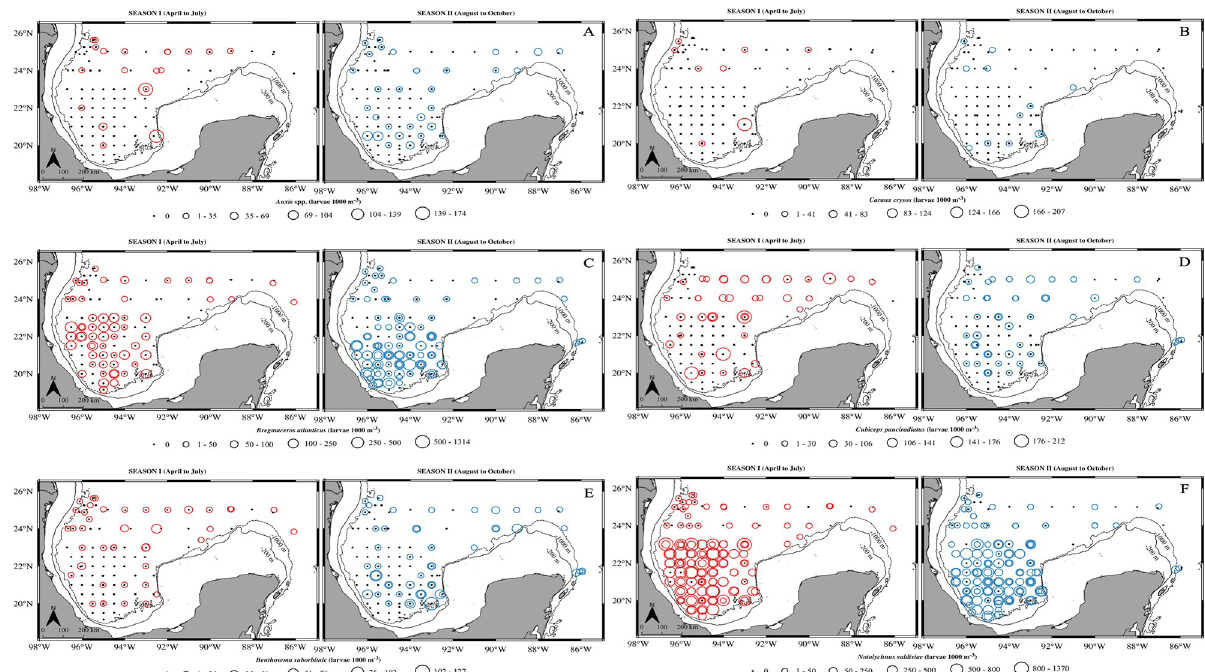
Fig 2. Season-specific spatial distribution of density of larval fish taxa. A: Auxis spp., b: Caranx crysos , c: Bregmacero s atlanticus , d: Cubiceps pauciradiatus , e: Benthosema suborbitale , f: Notolychnus valdiviae . First (second) column with red (blue) dots represents season I: April-July (season II: August-October). Circle size represents the density (larvae 1000 m -3 ) for a given location, with the scale adjusted for each species. Overlapping circles indicate samples from different cruises. Black dots indicate the absence of larvae. Continuous and dashed lines represent the 200 m and the 1000 m isobaths, respectively. https://doi.org/10.1371/journal.pone.0280422.g002 (Table 5). The models for the neritic C . crysos had a very low explained deviance ( < 0.1) in both seasons and were discarded. For Auxis spp., season I was the model with the highest explained deviance, and all models in season I presented a higher deviance explained than in season II (Table 5). In addition, station position also influenced in several models (Table 5). The relationship between the raw data of all species’ standardized densities and oceanographic variables are presented in S2 Fig. For season I, the final Auxi s spp. model included 4 oceanographic variables that were signif- icantly related to larval density: SST, WS, chl a and SSH (listed in order of the highest